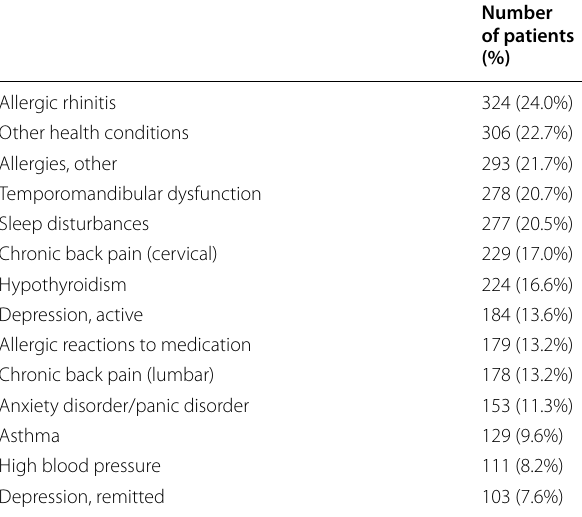
Table 4 Concomitant health